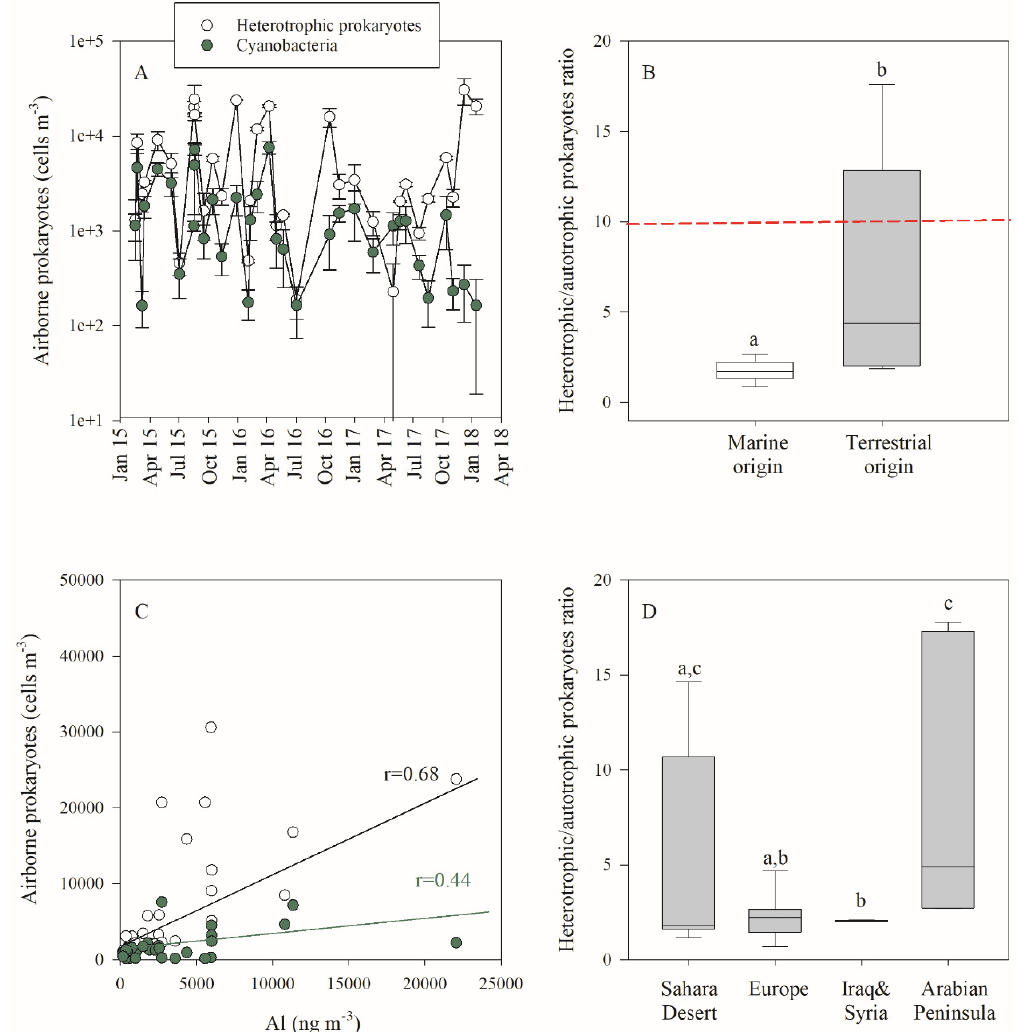
Figure 3. ( A ) Temporal variability of dust-associated airborne heterotrophic (white) and autotrophic (green) bacteria between 2015–2018 at the SE Mediterranean coast. Values presented are the averages and corresponding standard deviation in each time point ( n = 3). ( B ) The relationship between autotrophic and heterotrophic airborne prokaryotes based on air-mass back trajectories. The dashed red line signifies the ‘typical’ heterotrophic to autotrophic prokaryotic ratio in the SE Mediterranean seawater. ( C ) The relationship between Al concentration and airborne heterotrophic (white) and autotrophic (green) bacteria (Pearson linear regression, p < 0.05). ( D ) The relationship between autotrophic and heterotrophic airborne prokaryotes based on the main backward trajectory prior dust/aerosols collection. The horizontal line within the box represents the median value. The letters above the box-plots represent significant differences (ANOVA, p < 0.05) for mean values between sampling sites.